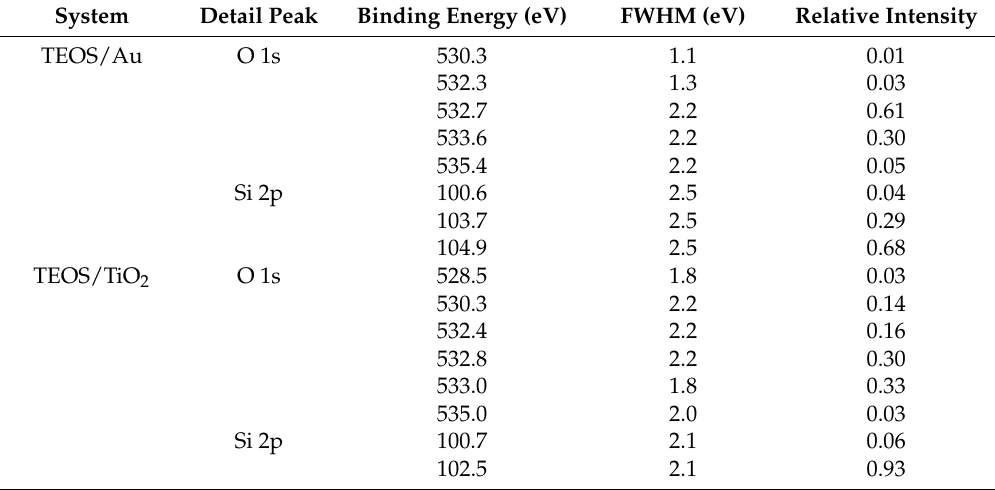
Table 1. Summarized XPS results from the particles coated with TEOS as